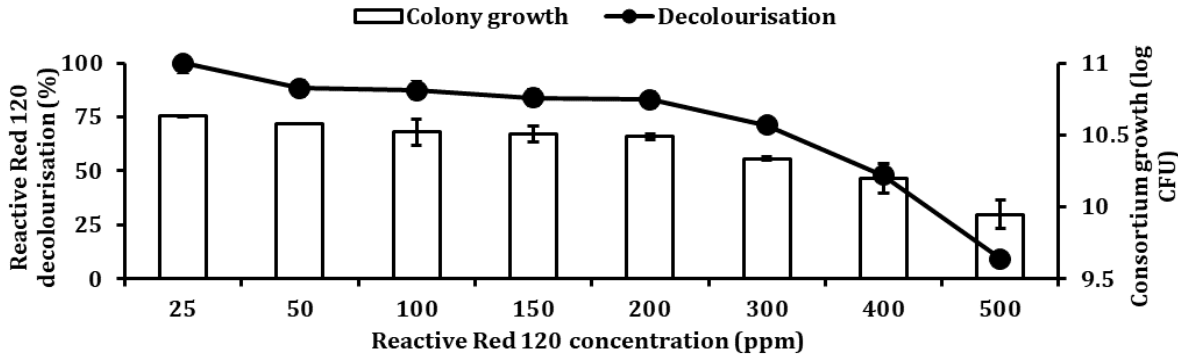
Figure 13. Effects of different Reactive Red 120 concentration on decolourisation by consortium JR3. Data represent mean ± SD, n = 3.